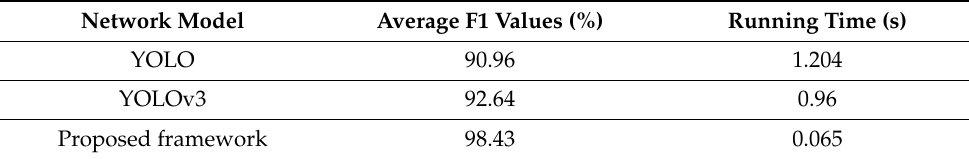
Table 2. F1 values and running times of YOLO and the proposed framework.